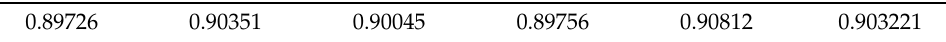
Table 7. Accuracy in every k-fold.